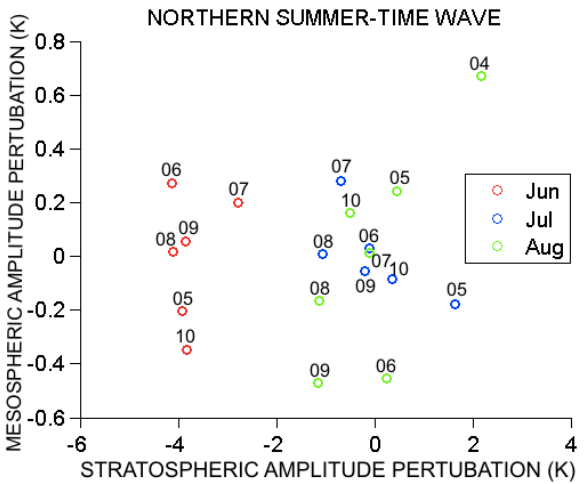
Fig. 9. Southern summer-time wave amplitudes for the winter stratosphere and summer